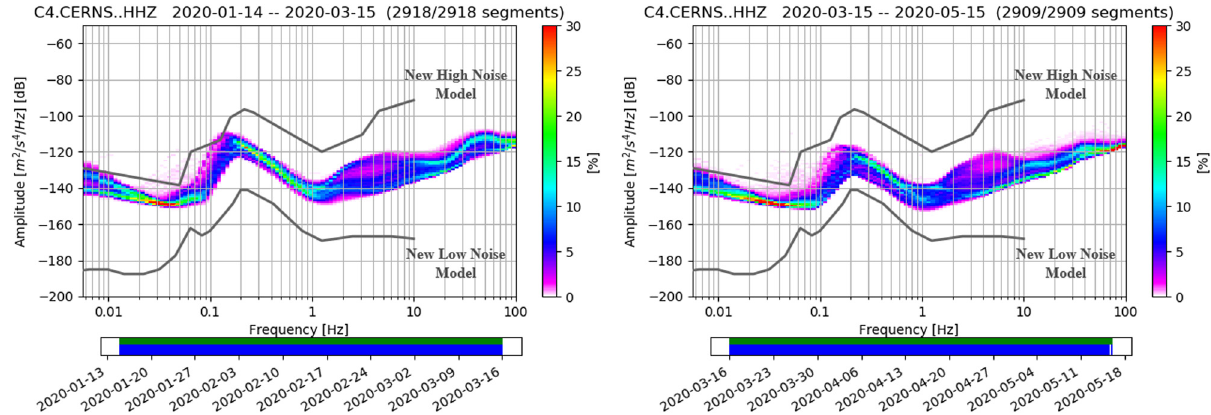
Figure 8: Probabilistic Power Spectral Density of CERN Seismic Station at the surface ( CERNS ) calculated over a period of 2 months before ( left graph ) and 2 months after ( right graph ) the CERN COVID - 19 closure.